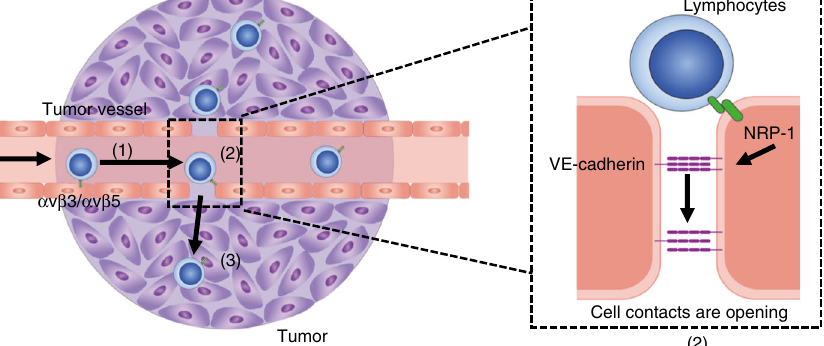
Fig. 4 Potential mechanism of the effects exerted by iRGD on the extravasation of lymphocytes in tumors. a iRGD induced tyrosine phosphorylation of VE- cadherin in endothelial cells. Endothelial cells were incubated with iRGD and subjected to immunoprecipitation of VE-cadherin at the indicated time. The immunoprecipitate was then analyzed by immunoblotting using either anti-phospho-tyrosine or anti-VE-cadherin antibody. b The amount of tyrosine- phosphorylated VE-cadherin in panel ( a ) was quanti fi ed by densitometry from three independent experiments and expressed as fold-increase of untreated controls. Data represent mean ± s.e.m.; Student ’ s t test. *** p < 0.001. c Anti-NRP-1 antibody and PI3K γ / δ inhibitor TG100 – 115 blocked iRGD-induced tyrosine phosphorylation of VE-cadherin. Endothelial cells were incubated with 15 μ g ml − 1 anti-NRP-1 antibody, control sheep anti-IgG or 3.5 μ g ml − 1 TG100-115 prior to iRGD incubation, tyrosine phosphorylation of VE-cadherin was analyzed by immunoprecipitation. d Schematic diagram of iRGD working mechanism. Circulating iRGD-modi fi ed T cells tether and roll in blood fl ow via the engagement of α v β 3/ α v β 5 expressed on tumor vascular endothelial cell, slowing its velocity ( 1 ). The interaction also initiates the proteolysis of iRGD and expose the CendR motif. The truncated peptide then bind to NRP-1, triggering the tyrosine phosphorylation of VE-cadherin and the formation of intercellular gaps ( 2 ).The connected lymphocytes then cross the vessel wall and in fi ltrate into tumor parenchyma ( 3